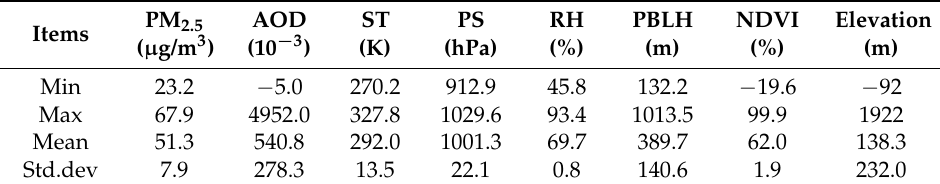
Table 1. Summary of